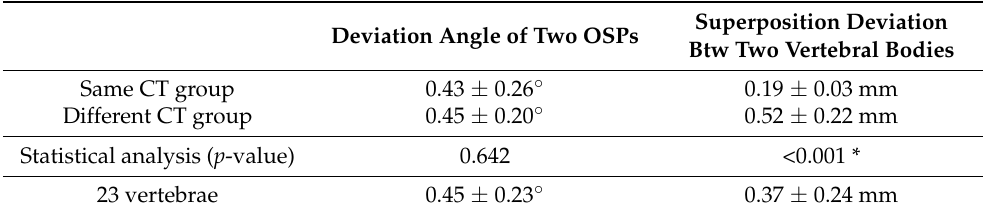
Table 1. Comparisons of deviation angles and superposition deviations between two groups. Deviation Angle of Two